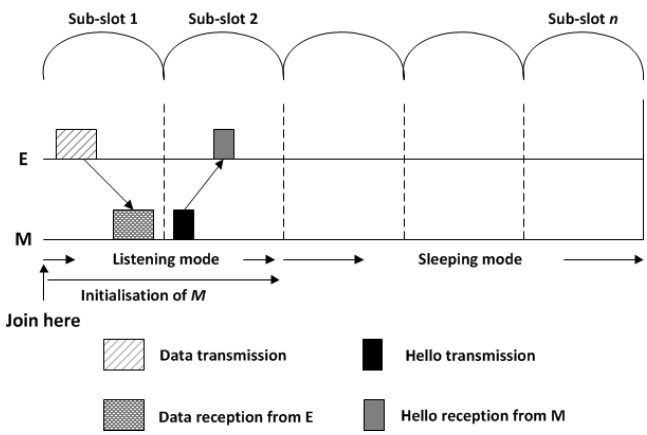
Figure 8. New node M joins the